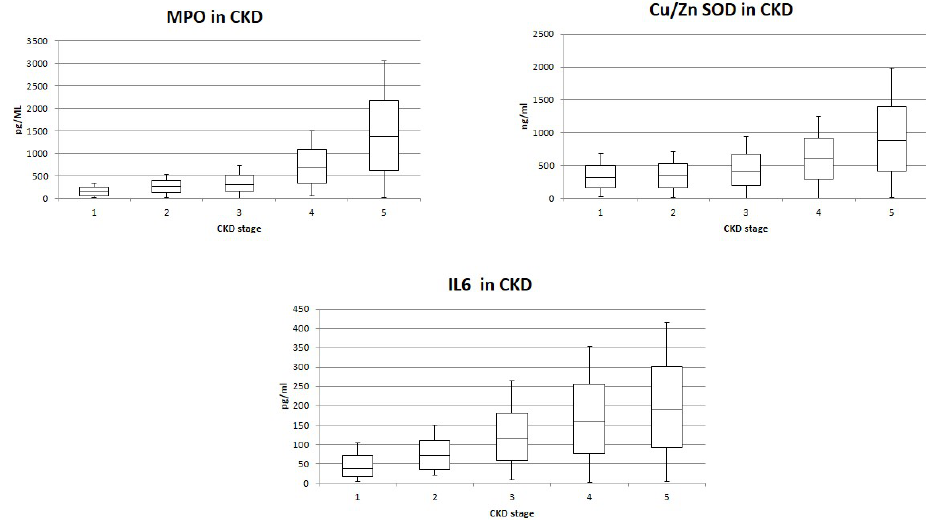
Figure 2. MPO, CU/Zn SOD and IL-6 levels in different CKD stages.